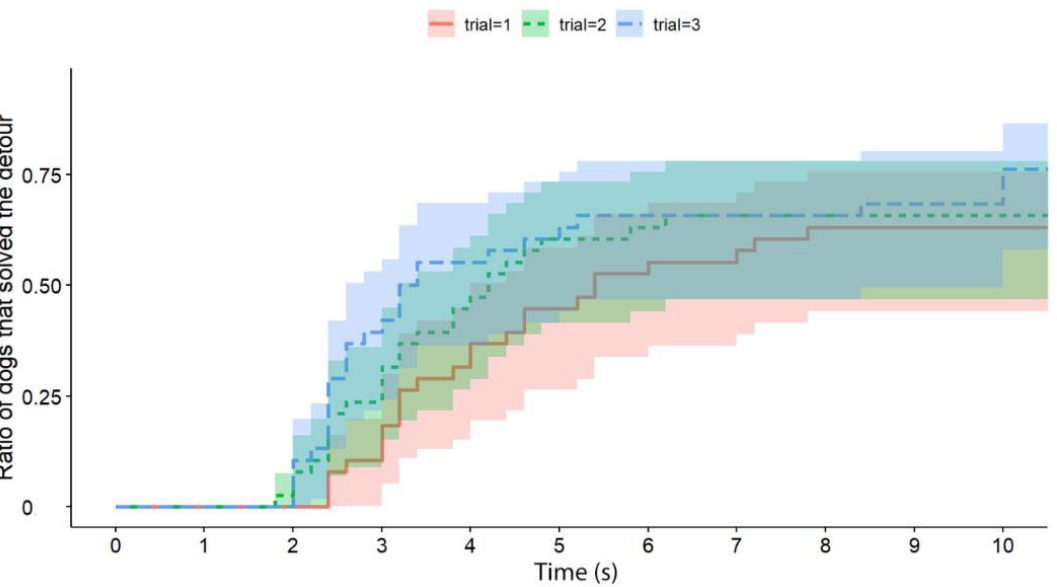
Figure 3. The latency of successful detours by the dogs (all experimental groups together; the Trials are shown separately). The latencies of successful detours are indicated on the horizontal axis, and the vertical axis shows the proportion of subjects (only dogs; the trials are shown separately) that successfully solved the task with a given latency.